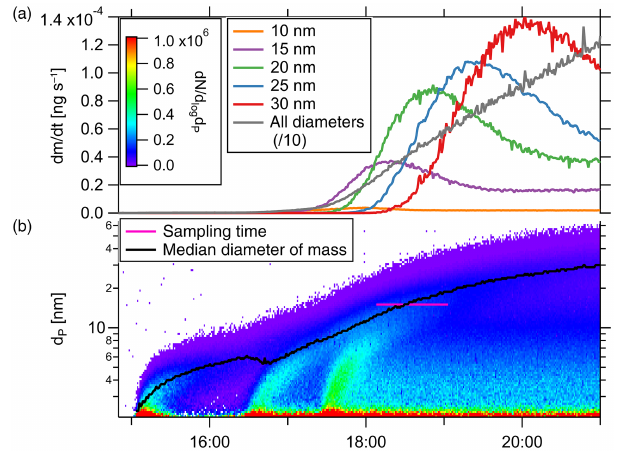
Figure 9. Particle mass collected by the TD-DMA per unit time when the instrument is set to collect a certain diameter (a) , for a given size distribution (b) .